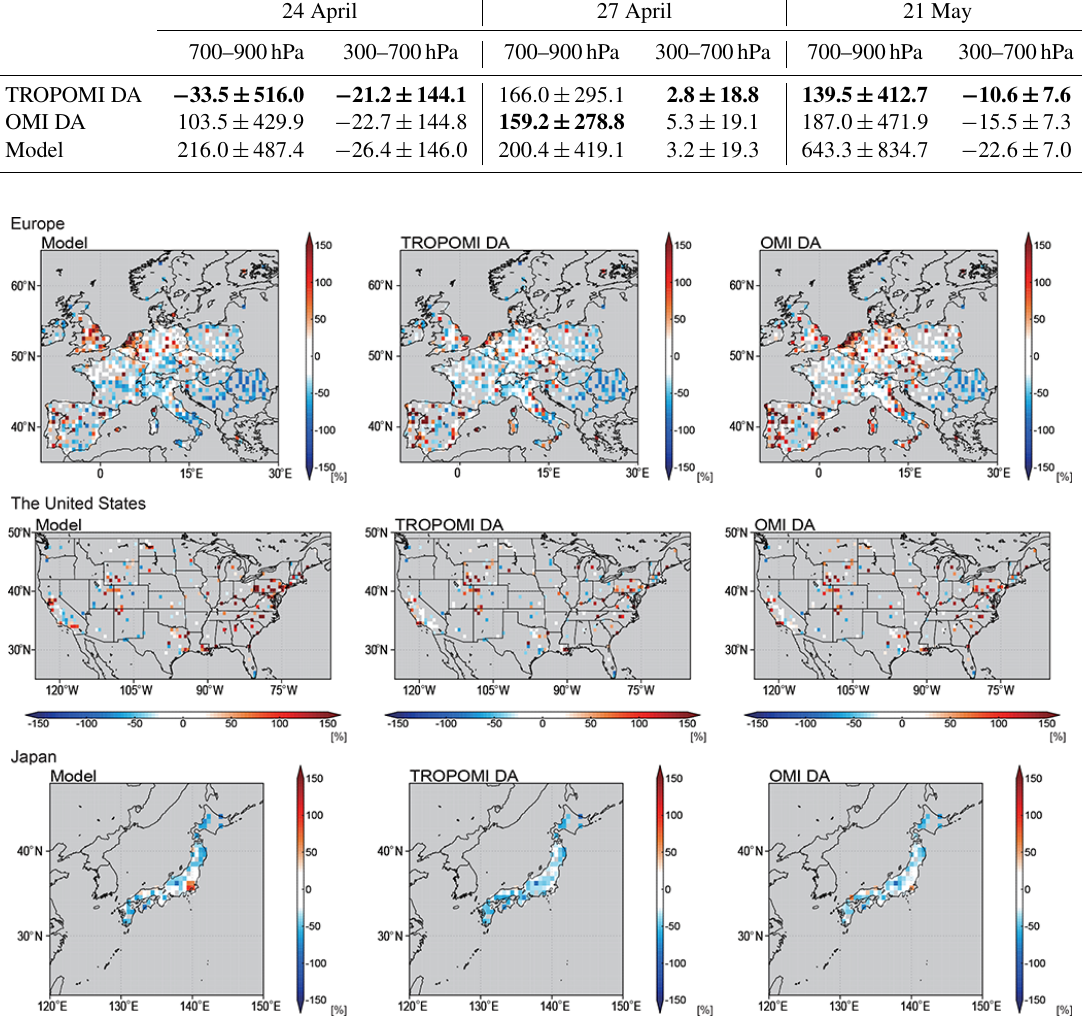
Figure 5. Mean model biases against surface in situ observations for surface NO 2 concentrations (%) at 14:00LT (local time) derived from the control model simulation (left column), Tropospheric Monitoring Instrument (TROPOMI) data assimilation (DA) (middle column), and Ozone Monitoring Instrument (OMI) DA (right column) over Europe (top), the United States (middle), and Japan (bottom). The values are mapped onto 0.56 ◦ resolution